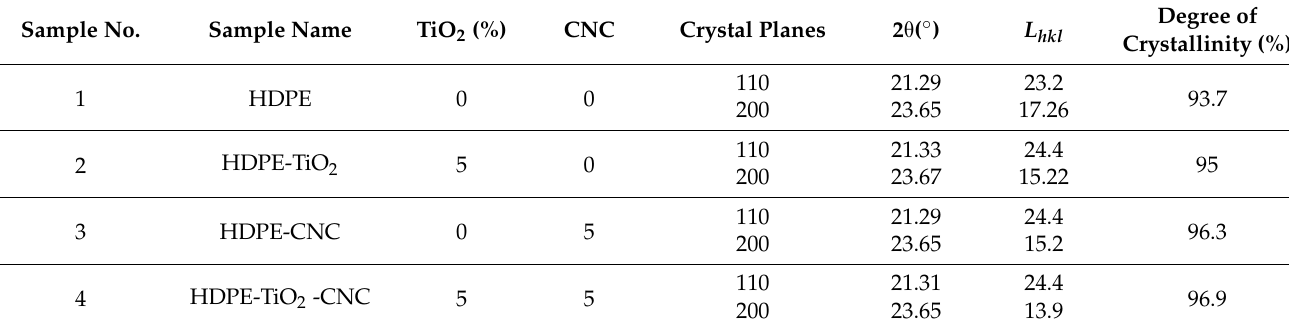
Table 3. XRD results for the HDPE/TiO 2 /CNC